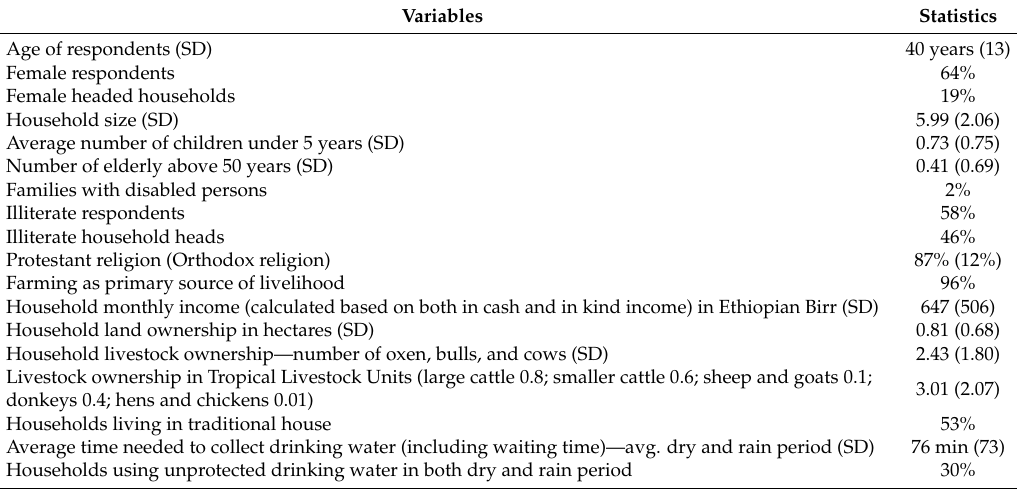
Table A1. Selected descriptive characteristics of the sample ( N = 368).